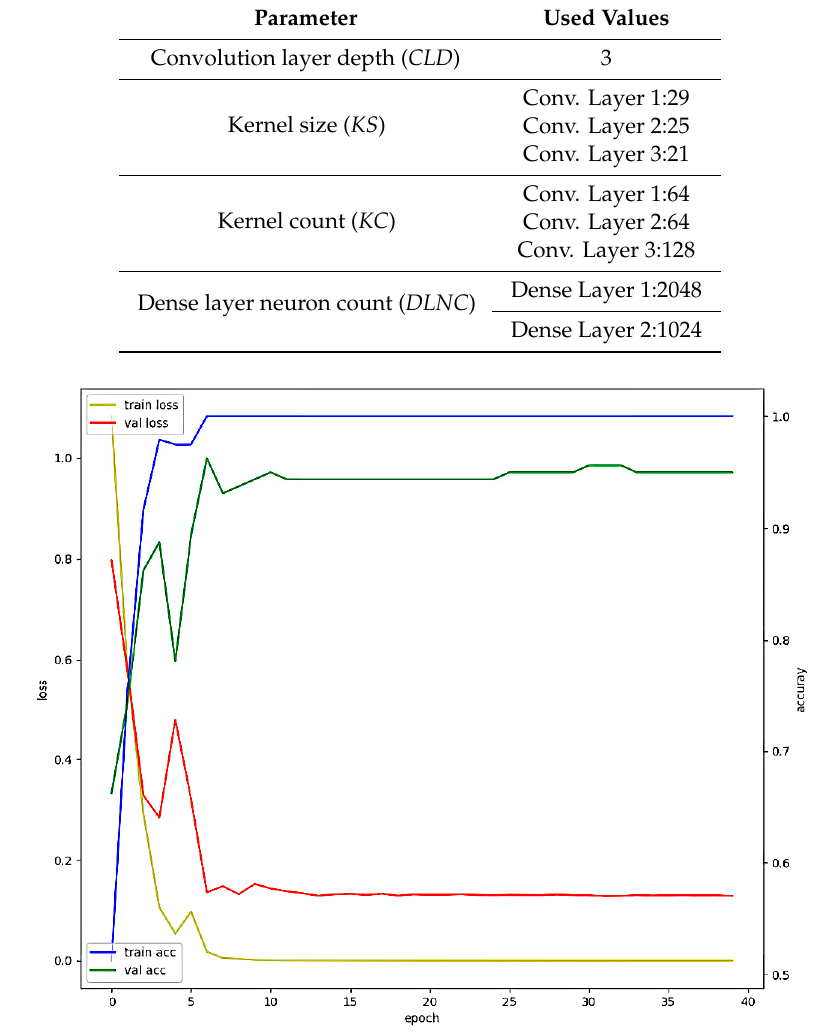
Figure 15. The results of performance obtained by using the optimal parameters of the proposed 1 D CNN model.